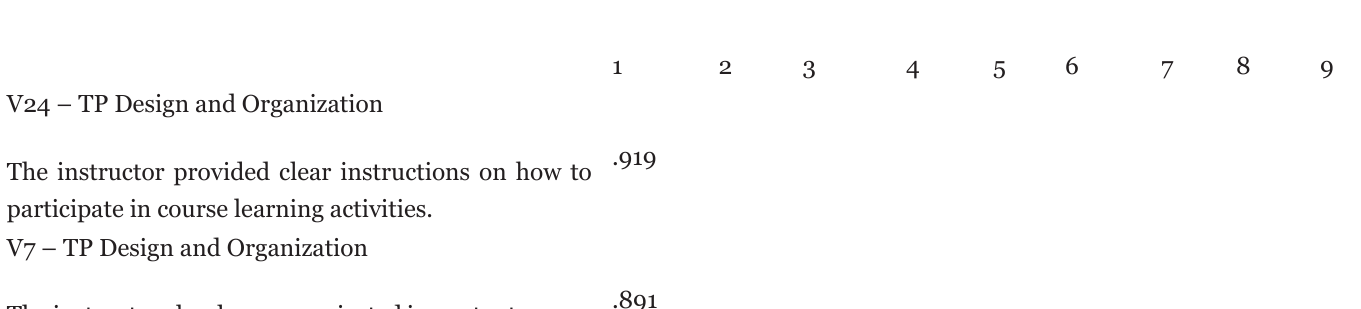
Factor Analysis – Nine